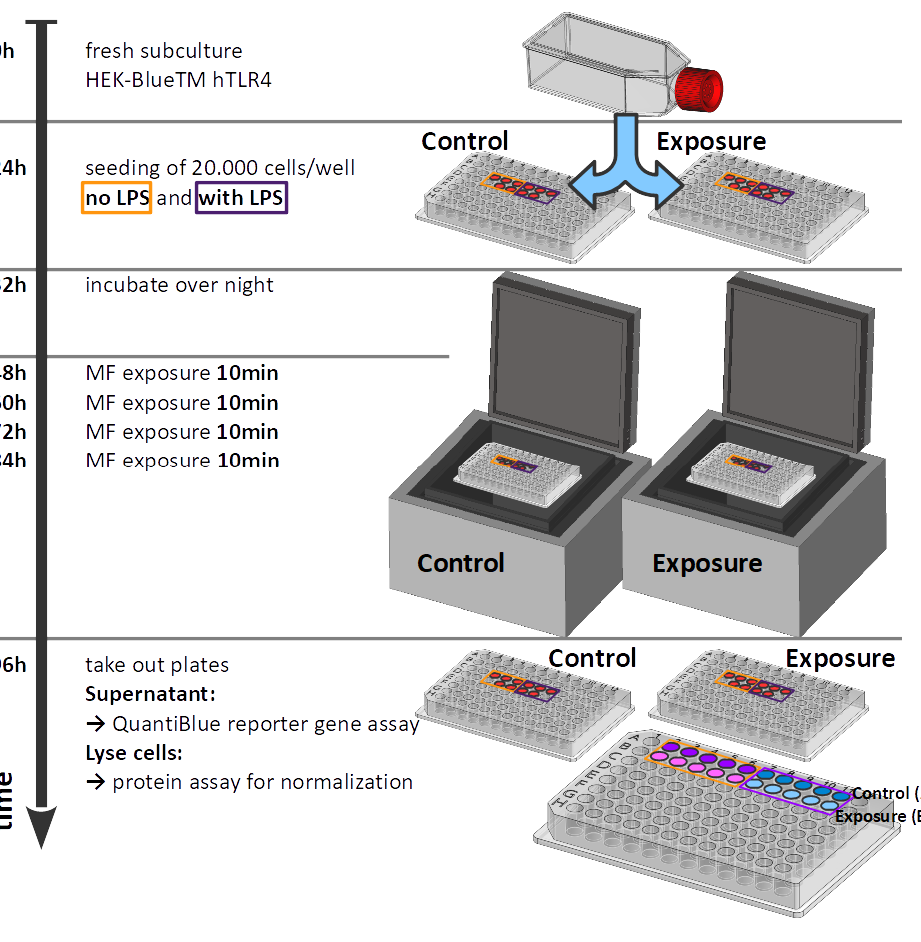
Figure 3. Time sequence of the